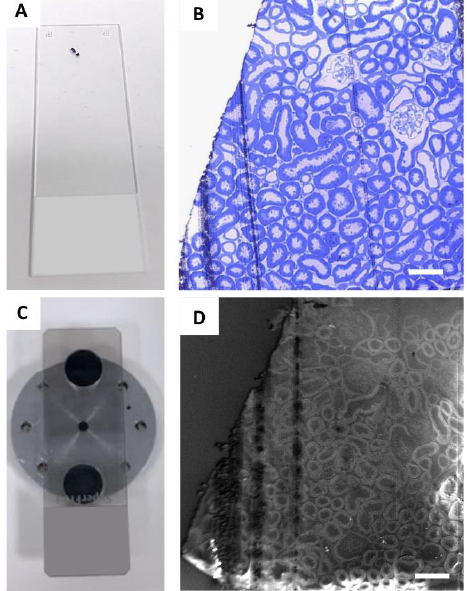
Figure 1. Identification of glomeruli for SE–SEM analysis: ( A ) regions of interest were identified on semi-thin sections, collected on a standard glass slide, and stained with toluidine blue ( B ) and observed with light microscopy; ( C ) for SE–SEM analysis, sections were collected on carbon-coated slides, mounted on an SEM specimen holder and ( D ) observed with SEM, with secondary electrons. Scale bars: 100 µ